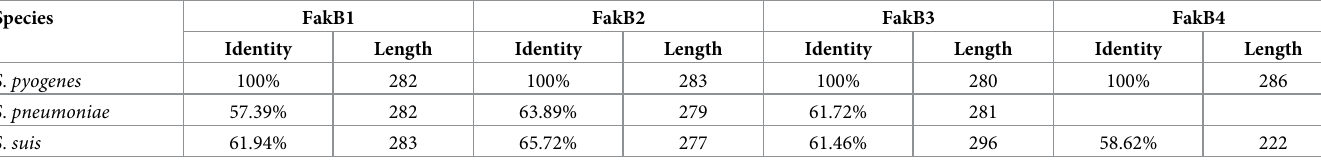
controlled by FabT in the M1 strain [15] and a FASII coregulation may shed light on the func- tion of the protein. We therefore tested whether fakB4 present in the M28PF1 strain is coregu- lated with FASII genes. We compared by qRT-PCR, the relative expressions of fabT , that is self-repressed, and fakB4 in a fabT mutant strain (mFabT, S3 Table) versus in the WT strain. The mFabT strain expresses a FabT variant in which the histidine in position 105 was replaced by a tyrosine. The FabT H105Y mutation leads to derepression of the FASII genes (to be pub- lished elsewhere), as previously described for a S . pyogenes fabT mutant strain [15]. FabT co- repressors are long chain acyl-Acyl Carrier proteins (acyl-ACP) [17]. Strains were therefore grown in THY and in THY-Tween 80; Tween 80 provides, the long chain unsaturated fatty Table 1. Protein identity to S . pyogenes homologous FakB protein.